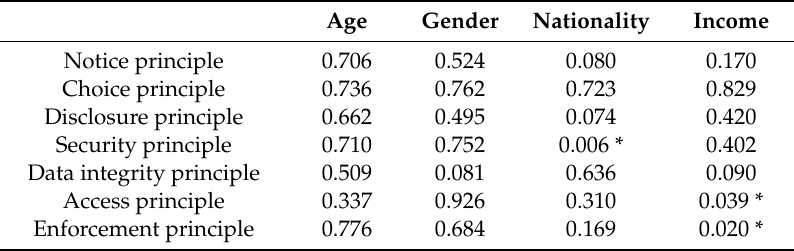
Table 4. Statistical associations between the perceptions of participants on privacy principles and the practice of providers and users and selected demographic variables.